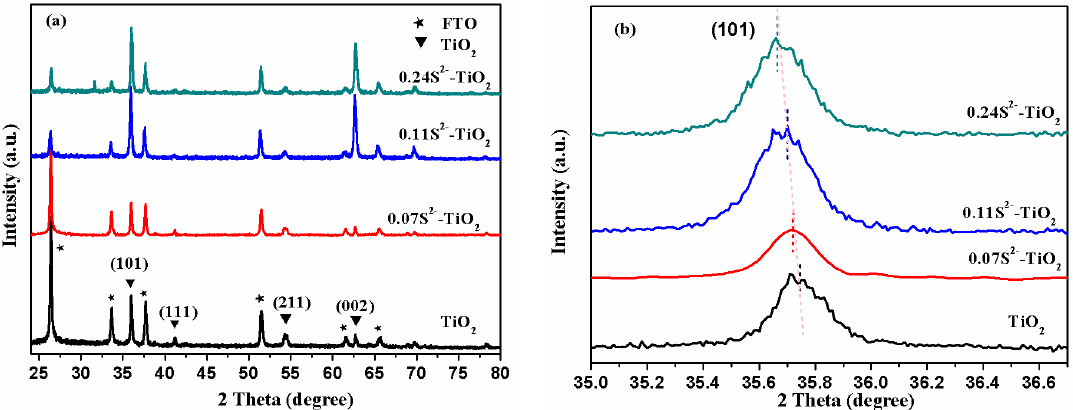
Figure 2. ( a ) X-ray diffraction (XRD) pattern of TiO 2 nanorod arrays (TNA), with different doping ratios. ( b ) The (101) planes diffraction peaks of S 2 − -TNA with different atomic percentage. To gain insight into the morphological and microstructures of the as-synthesized TNA and S 2 − -TiO 2 , samples were performed using field emission scanning electron microscopy (SEM) and transmission electron microscope (TEM), as shown in Figures 3 and 4.